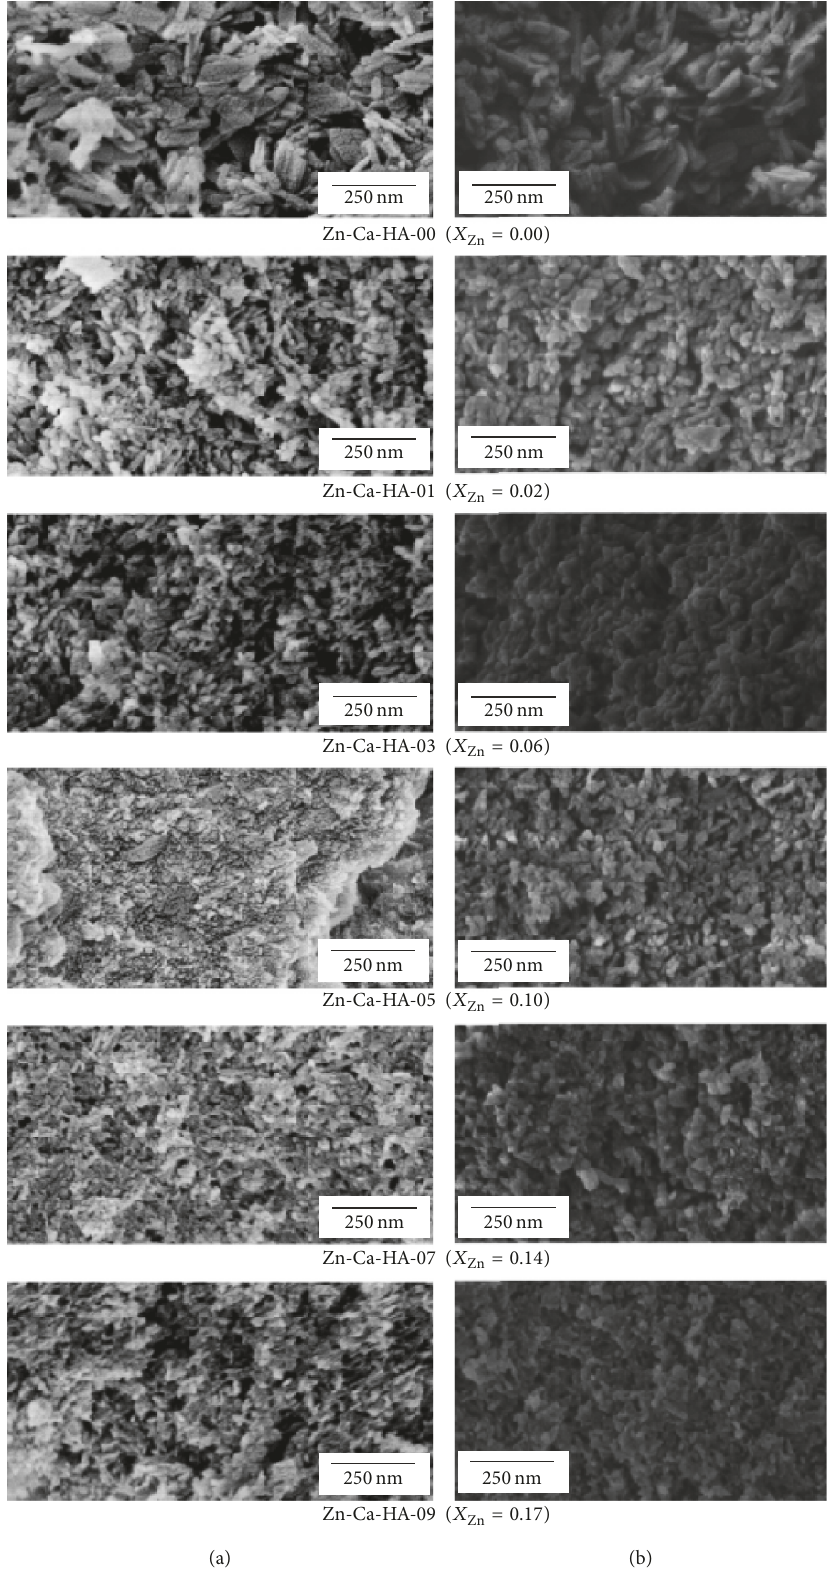
Figure 3: Field emission scanning electron micrographs (FE-SEM) of the Zn-substituted hydroxylapatites [(Zn dissolution (a) and after dissolution at 25 ∘ C with an initial pH of 2.00 for 360 d